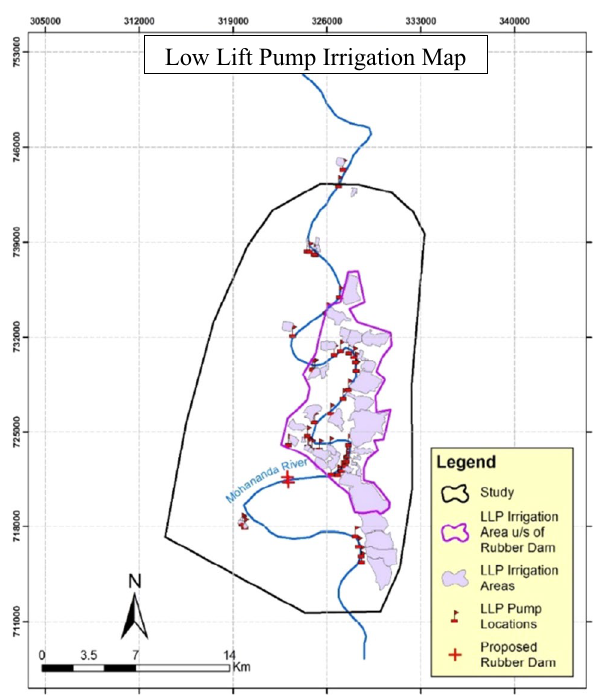
Fig. 2 The permanent LLP structure locations along the